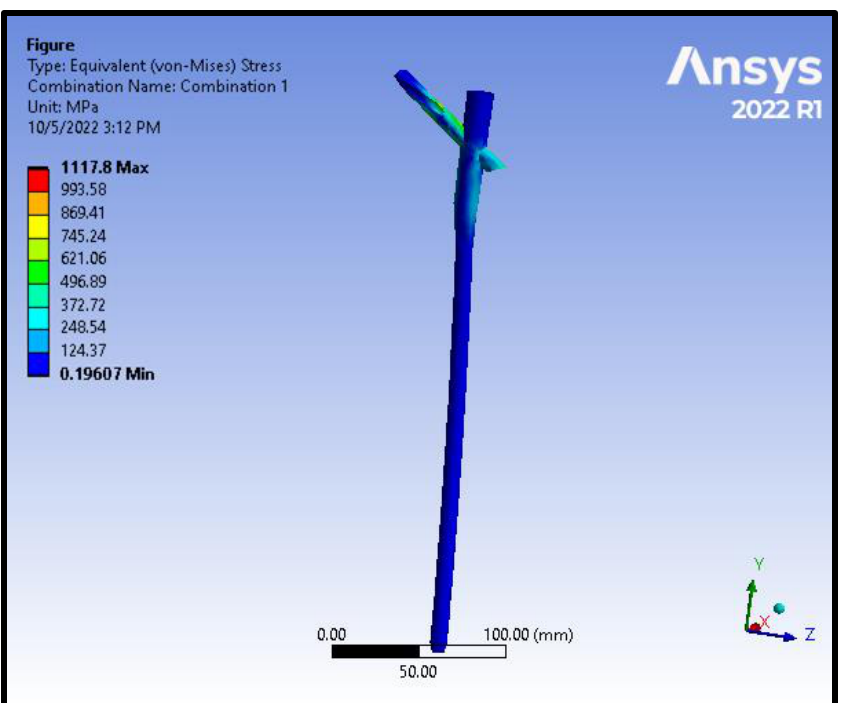
Figure 9. Shear stress distribution on the femoral model in an intracapsular fracture under axial compression and torsion scenario.